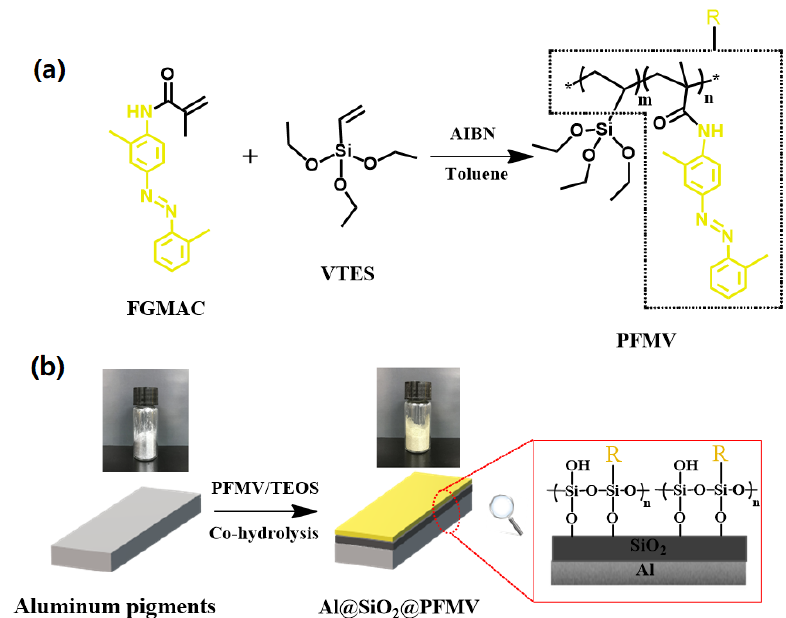
Figure 1. High-performance liquid chromatography (HPLC) chromatograms from Garcinia humilis rind and pulp for procyanidin analysis at 280